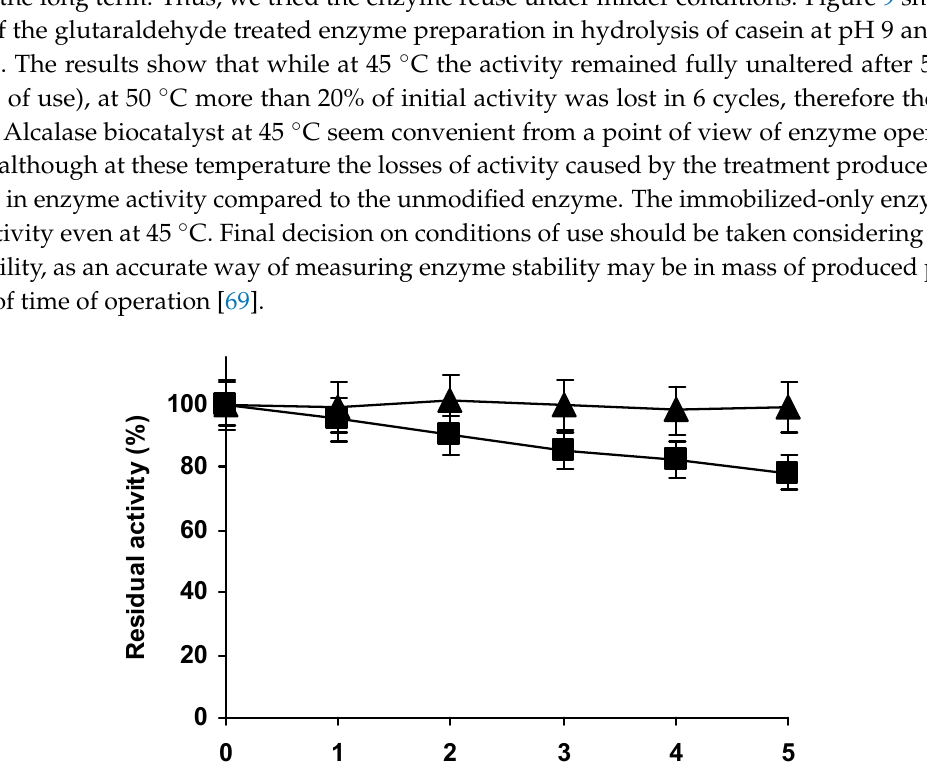
Figure 8. ( A ) Hydrolysis of casein by different preparations of Alcalase at 69 °C and pH 9. Reactions were performed using 0.005 mg of enzyme/mL. Other specifications are described in Methods section. Open circles, dashed line: Free enzyme; Solid triangles: Immobilized Alcalase; Solid Squares: Immobilized, aminated and glutaraldehyde modified enzyme; ( B ) Operational stabilities of different Alcalase preparations at 69 °C and pH 9. Other reaction conditions as in Figure 8A. Solid triangles: Immobilized Alcalase; Triangles, solid line: Immobilized, aminated and glutaraldehyde modified enzyme.